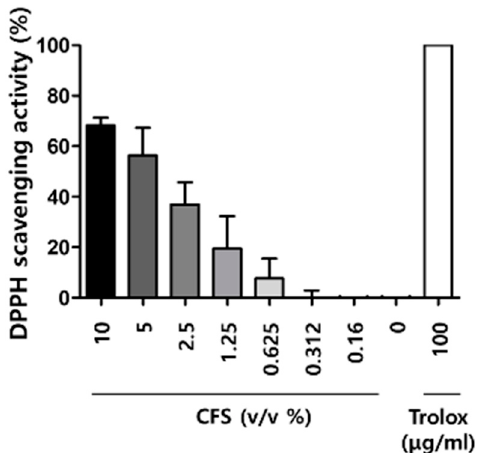
Figure 6. Effect of CFS on free radical scavenging activity by the DPPH assay. Trolox was used as positive control. CFS: cell-free supernatant from L. gasseri BNR17. Values represent the mean ± SD of three independent experiments.